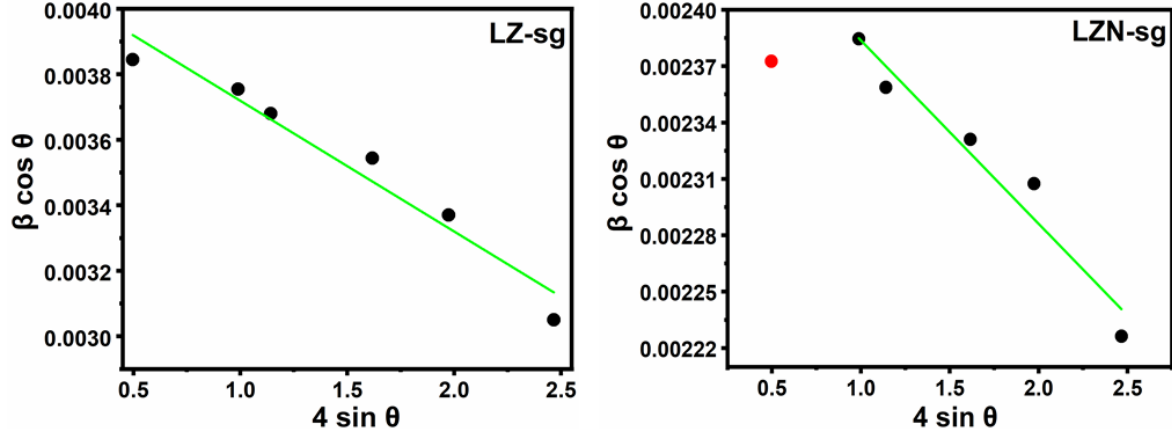
Figure 6. W – H plot of LZ-sg and LZN-sg (• = correct data point)